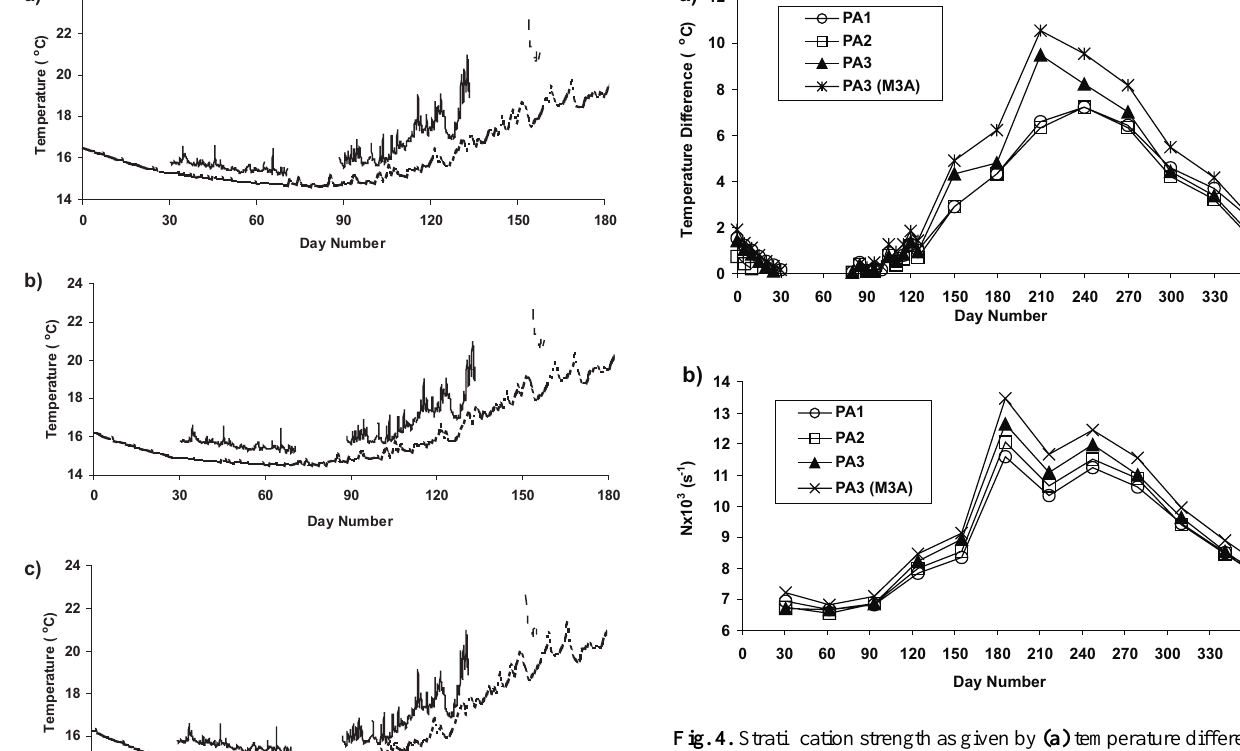
Fig. 4. Stratification strength as given by (a) temperature difference across the thermocline and (b) the monthly running-mean of the depth-averaged Brunt-V¨ais¨al¨a frequency, for runs PA1, PA2, PA3 and PA3 with M3A